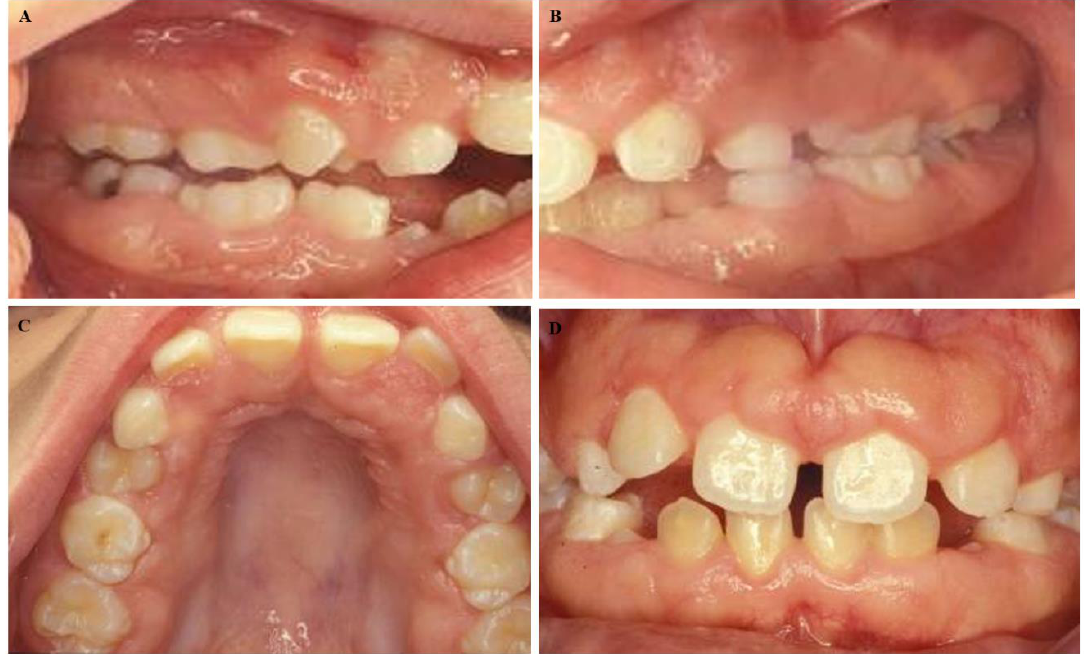
Figure 2. Intraoral images of the 12-year-old female daughter of the male patient in Figure 1. ( A – C ) We observed mixed dentition, ( D ) with malocclusion similar to her father, including an anterior open bite and delayed eruption.